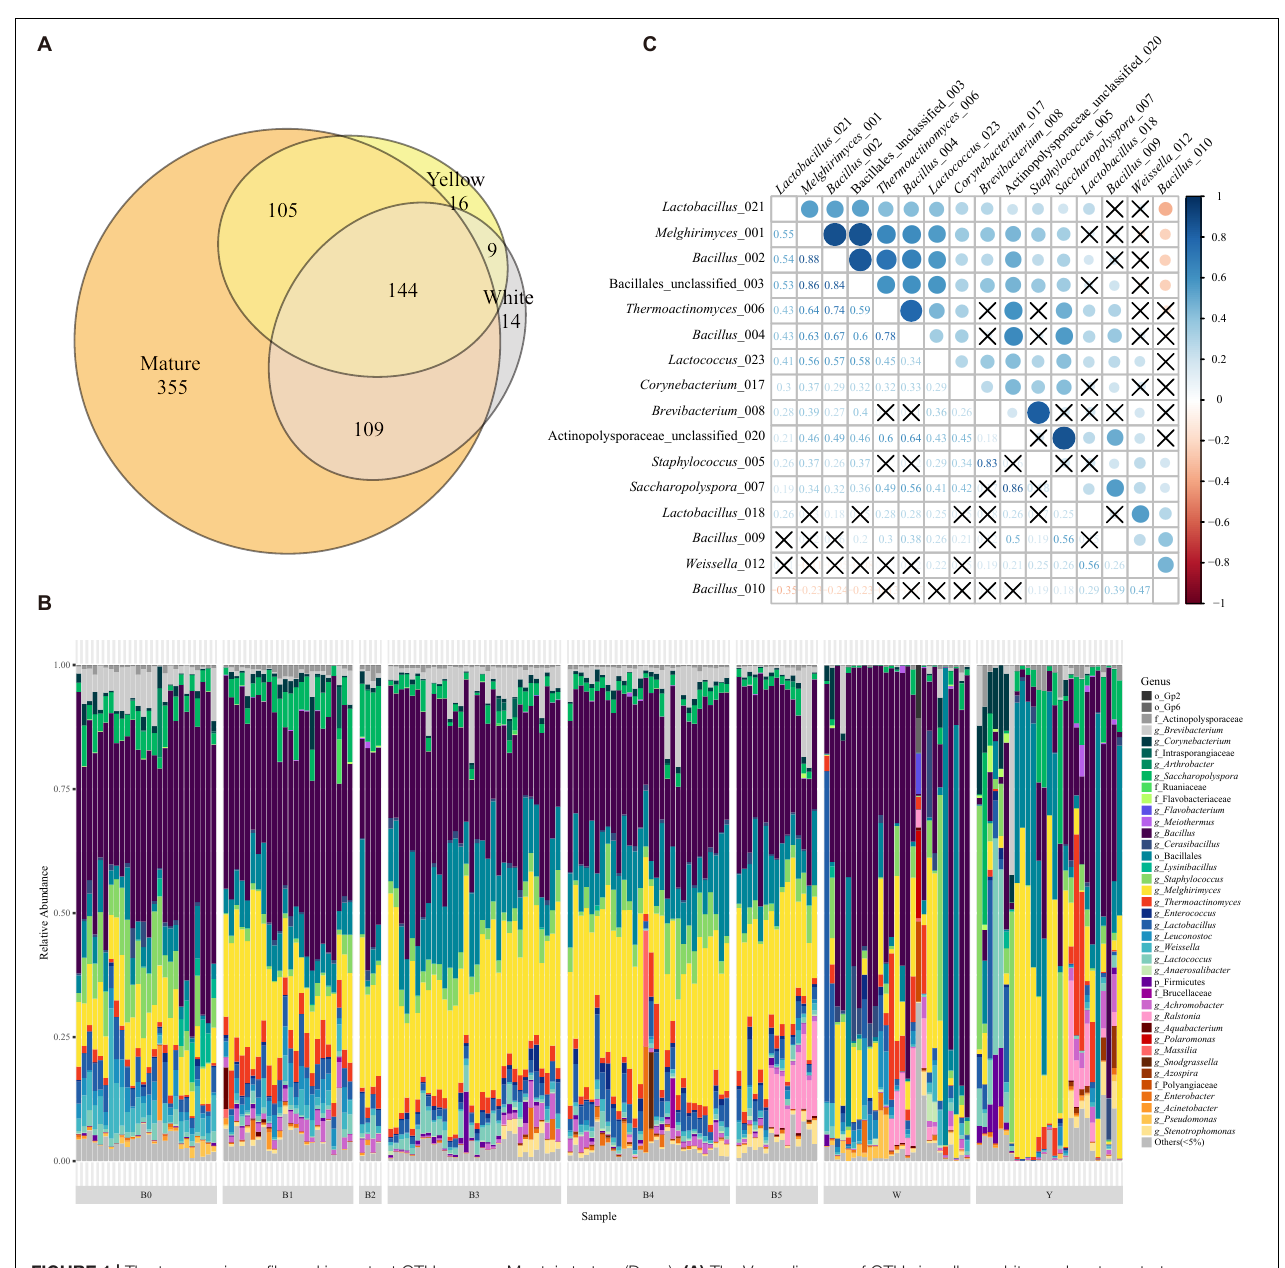
FIGURE 1 | The taxonomic profile and important OTUs among Moutai starters (Daqu). (A) The Venn diagram of OTUs in yellow, white, and mature starters. (B) Taxonomic profile and the relative abundance of all 185 samples based on 16S rRNA metagenomic sequencing. Shown are the lowest taxonomic levels the OTUs can be annotated to, including phylum (p_), order (o_), family (f_), and genus (g_). "Others ( < 5%)" includes all taxa less than 5%. W and Y stand for white and yellow immature starters. B0 to B5 stands for six batches of mature starters. (C) The Spearman correlations between 16 core OTUs present in more than 95% mature starter samples (significance level is 0.05, P value is adjusted in the FDR method). The labels are composed of the taxa and the last three numbers of OTUs original